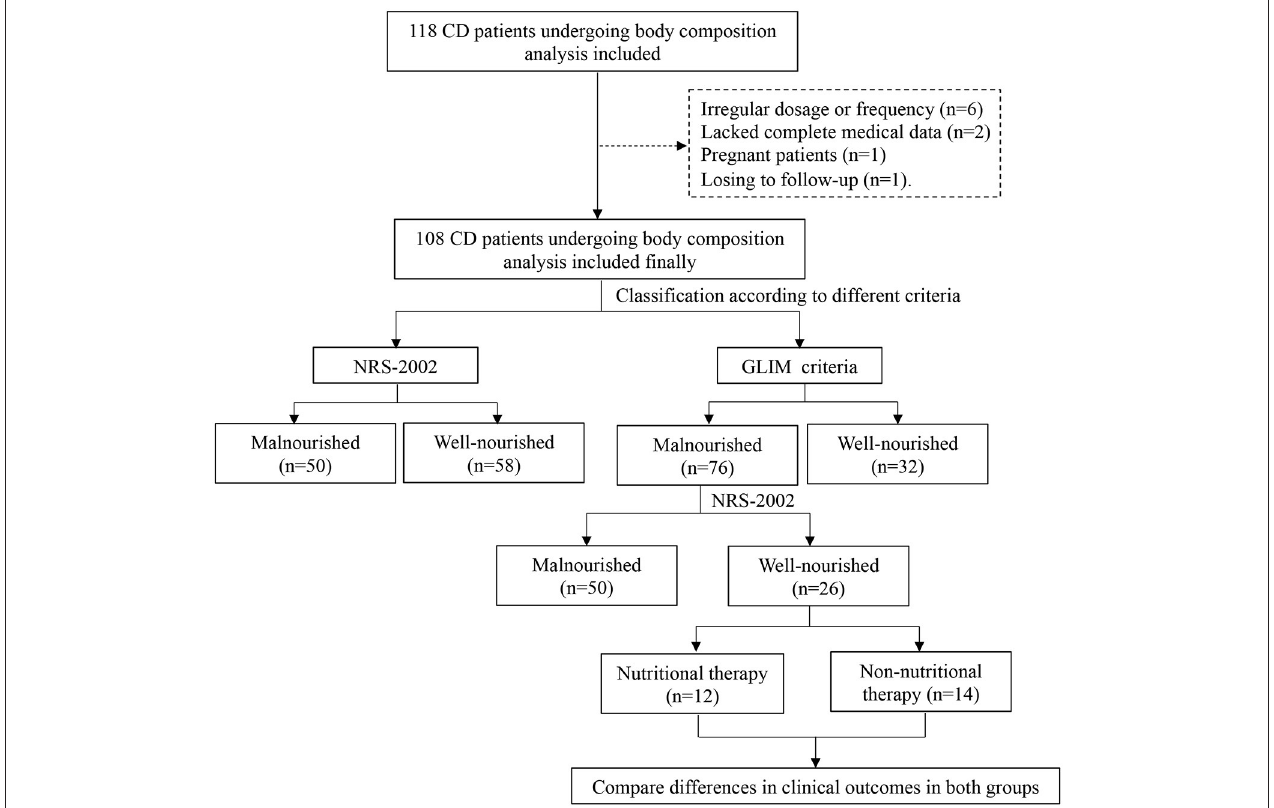
FIGURE 1 | A flow chart of the process of this